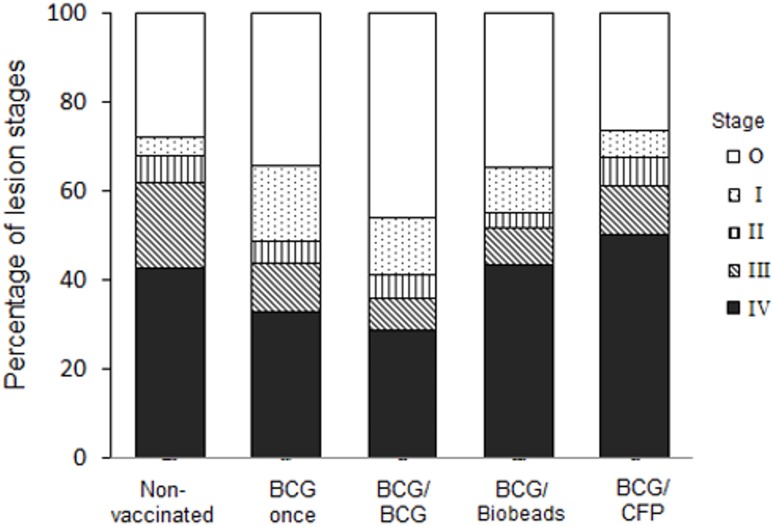
Histological evaluation of pulmonary lymph nodes following challenge with Mycobacterium bovis.Sections were stained with hematoxylin and eosin and the most severe stage of granuloma in each section was determined as described in the Material and Methods. The stage of granuloma was indicated by Stage 0 (no granuloma, white bars), Stage I (dotted bars), Stage II (vertically hatched bars), Stage III (diagonally hatched bars) and Stage IV (black bars). Data were shown as proportions for each stage. Non-vaccinated; BCG once, BCG-vaccinated, not revaccinated; BCG/BCG, BCG-vaccinated and revaccinated 2 years later with BCG; BCG/Biobeads, BCG-vaccinated and revaccinated 2 years later with TB biobeads displaying mycobacterial proteins, ESAT-6 and Ag85A; BCG/CFP, BCG-vaccinated and revaccinated 2 years later with M. bovis culture filtrate protein vaccine. The proportion of Stage III and IV granulomas combined for the BCG once and BCG/BCG groups were significantly less than that for the non-vaccinated group (p<0.05).